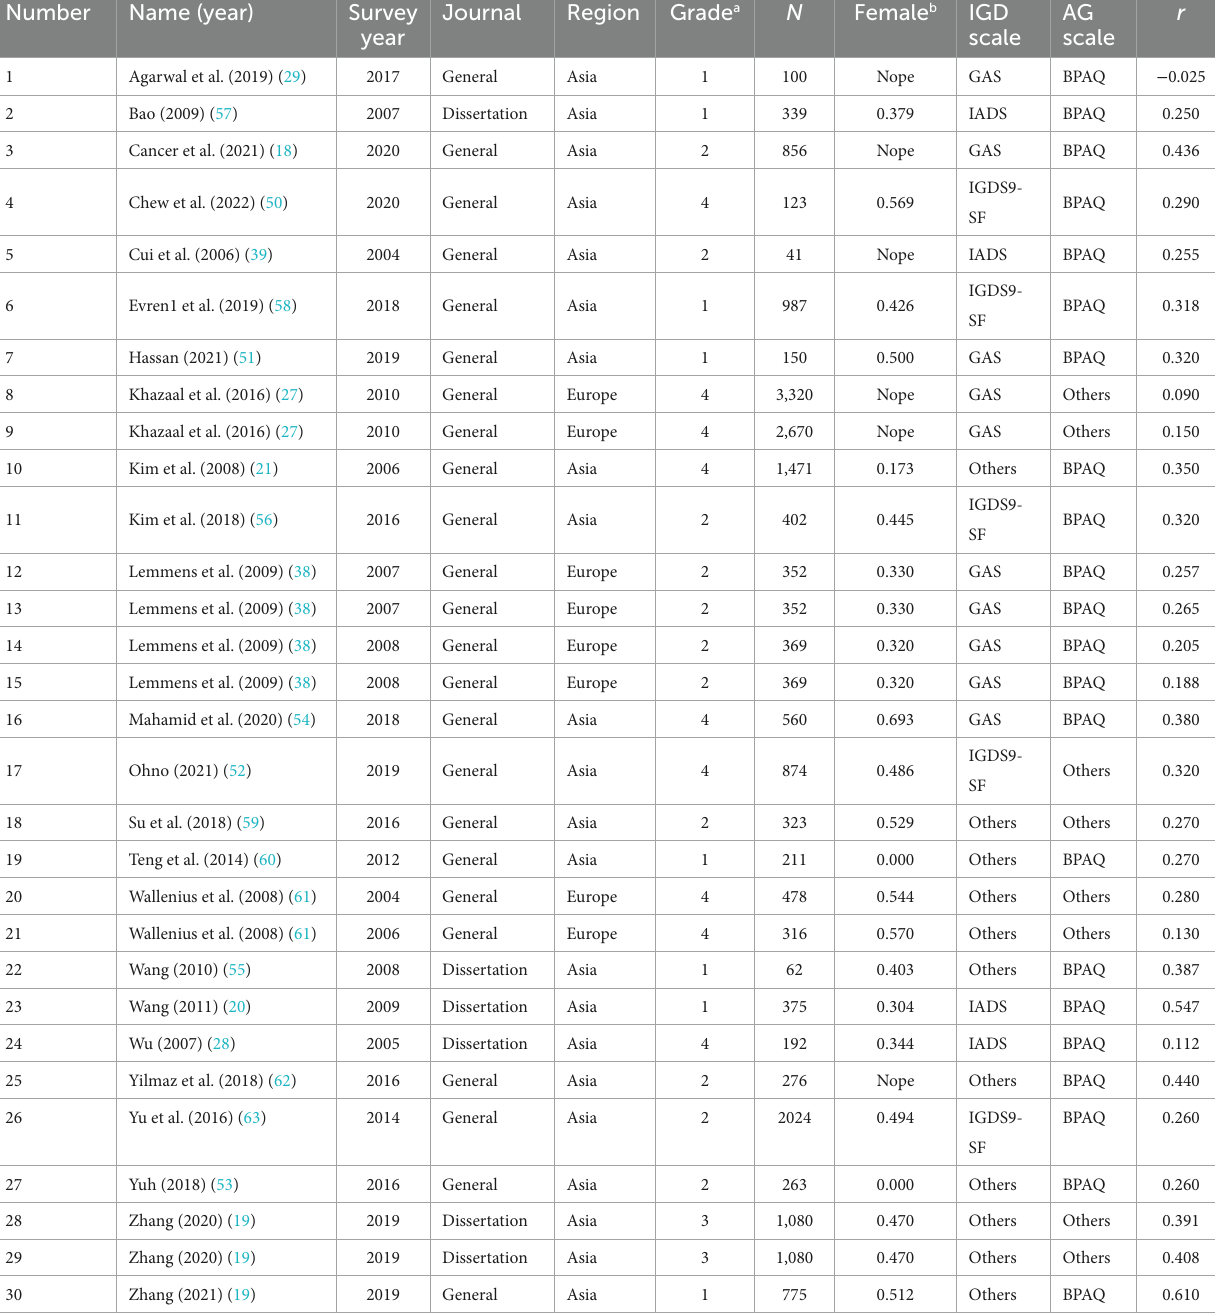
TABLE 1 Characteristics of the 30 samples included in the